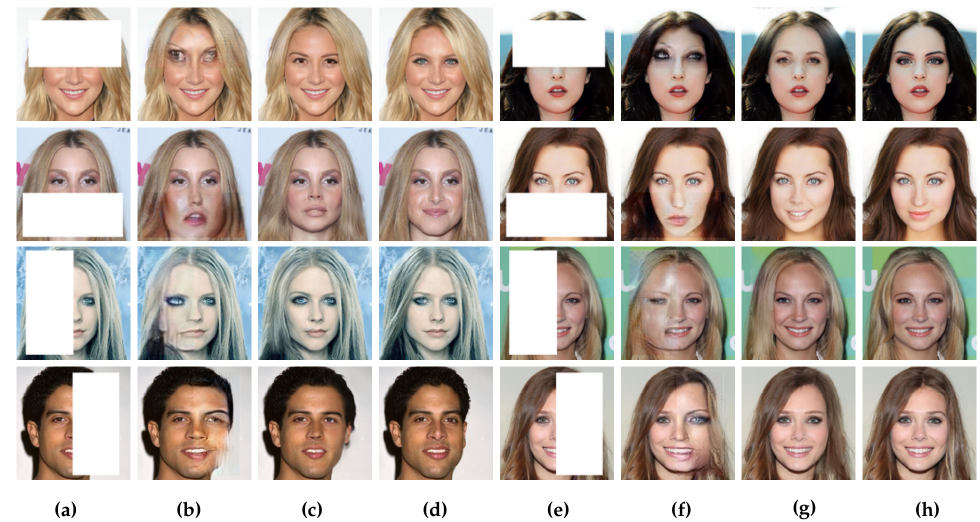
Figure 8. Completion results on the large-area rectangular masks. ( a ) Masked images. ( b ) GLCIC results [8]. ( c ) Our results. ( d ) Original images. ( e ) Masked images. ( f ) GLCIC results [8]. ( g ) Our results. ( h ) Original images.